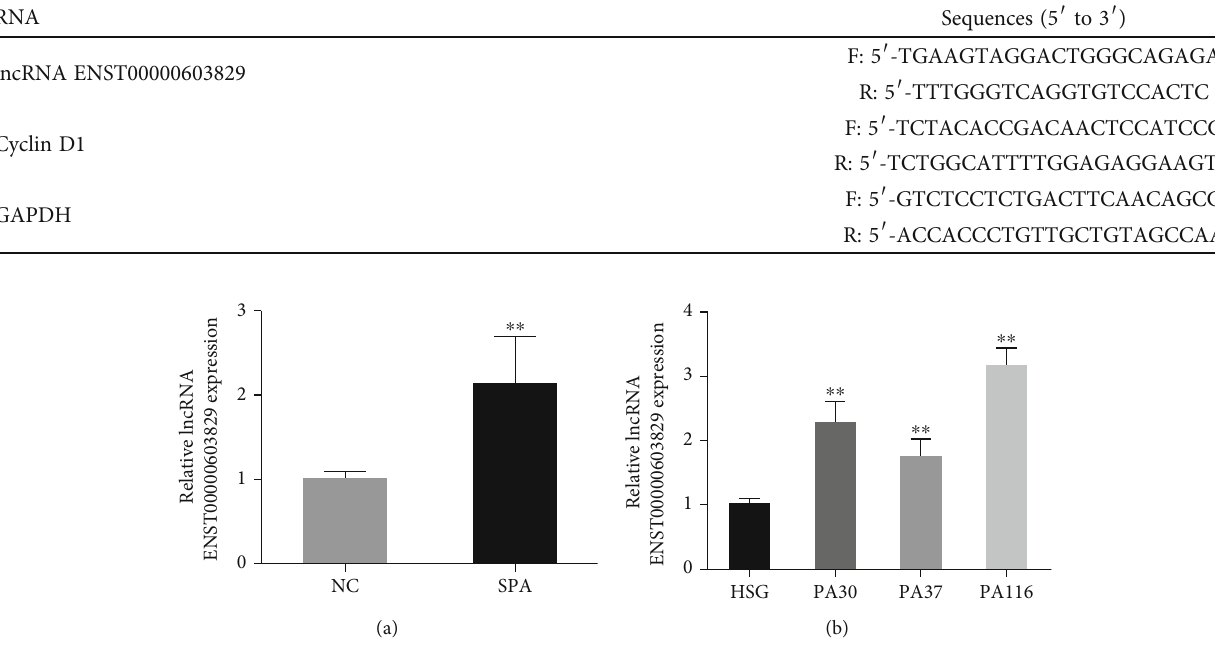
Table 1: Primer sequences for qRT-PCR.